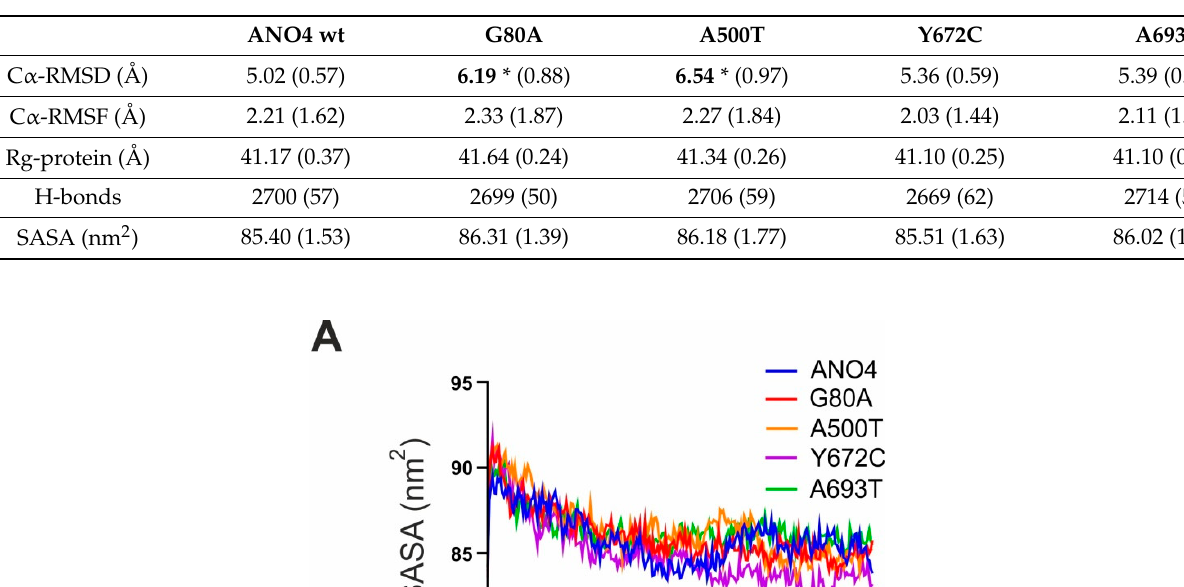
Table 2. Average structural properties calculated for the full length ANO4 wild-type, G80A, A500T, Y672C, and A693T structures and corresponding standard deviations (in parentheses). * Significant at p < 0.05 are depicted in bold and with asterisk.